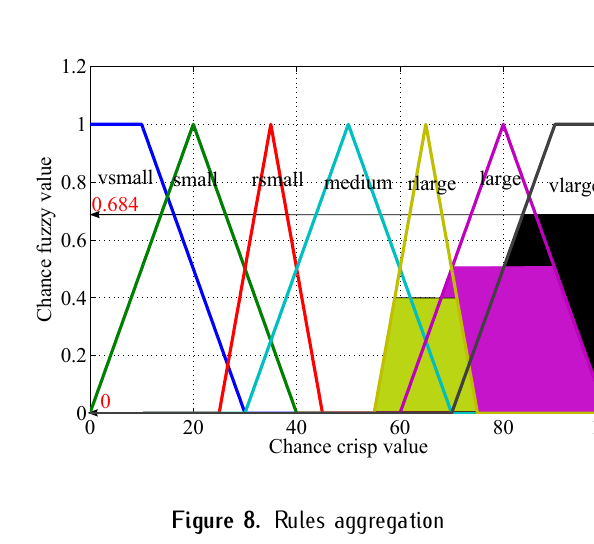
Figure 5. Fuzzification of the energy budget input